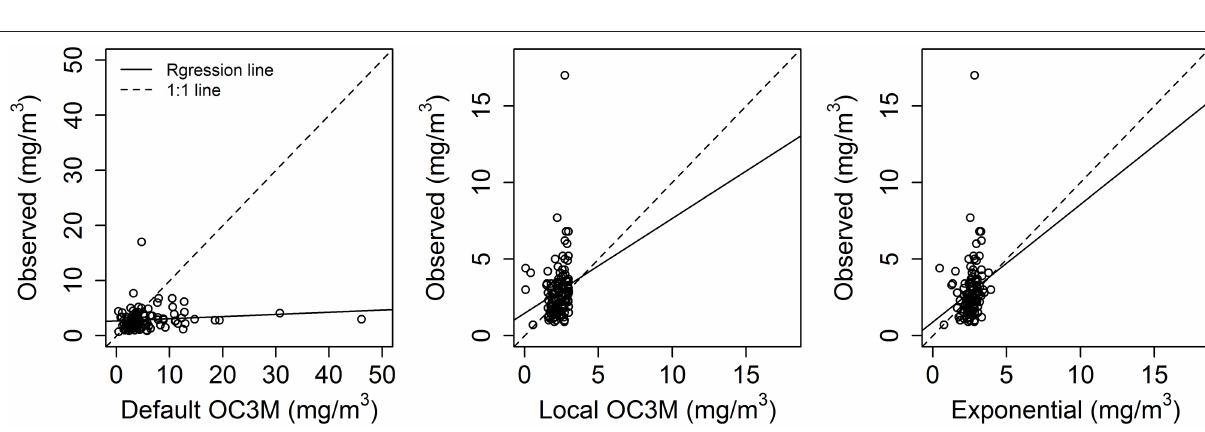
FIGURE 9 | Default (global Case 1) and local model predictions vs. 6 h averaged in situ State of the Environment (SOE) chlorophyll- a concentrations for the three different model approaches. Note: the different scale for the global OC3M